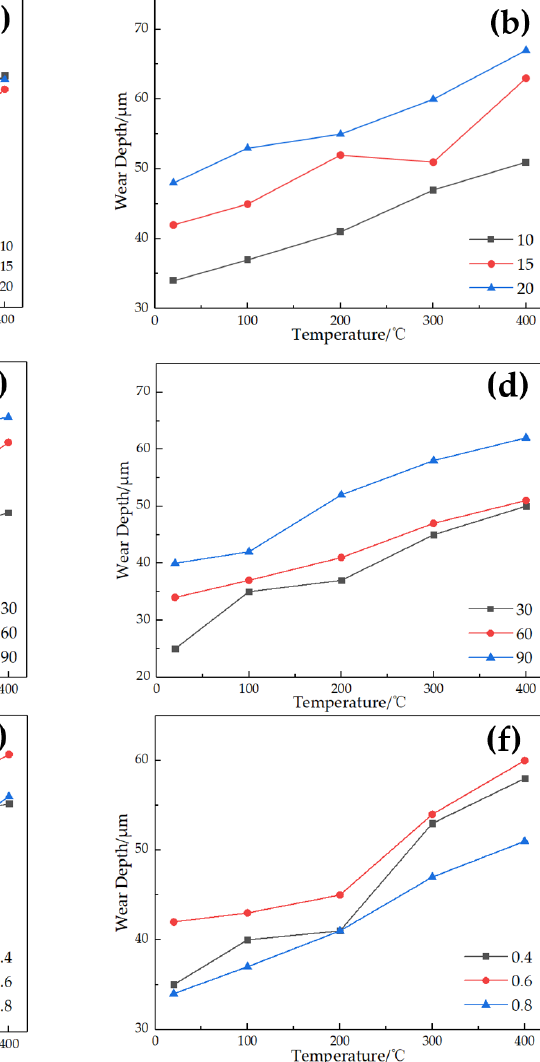
Figure 5. Variation in friction coefficient and wear depth with temperature under different param- eters: ( a , b ) loads; ( c , d ) crossing angles; ( e , f ) strokes. ( a , b ) loads; ( c , d ) crossing angles; ( e , f )